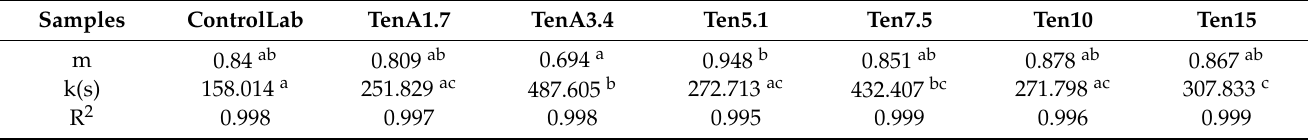
Table 2. The consistency coefficient (k), the deformation thinning rate (m), and the R 2 values of the different emulsions (Control, ControlLab, TenA1.7, TenA3.4, Ten5.1, Ten7.4, Ten10, and Ten15). The lower-case letters (a, b, and c) located above each bar represent the significant difference between formulations ( p < 0.05), according to the ANOVA calculation.